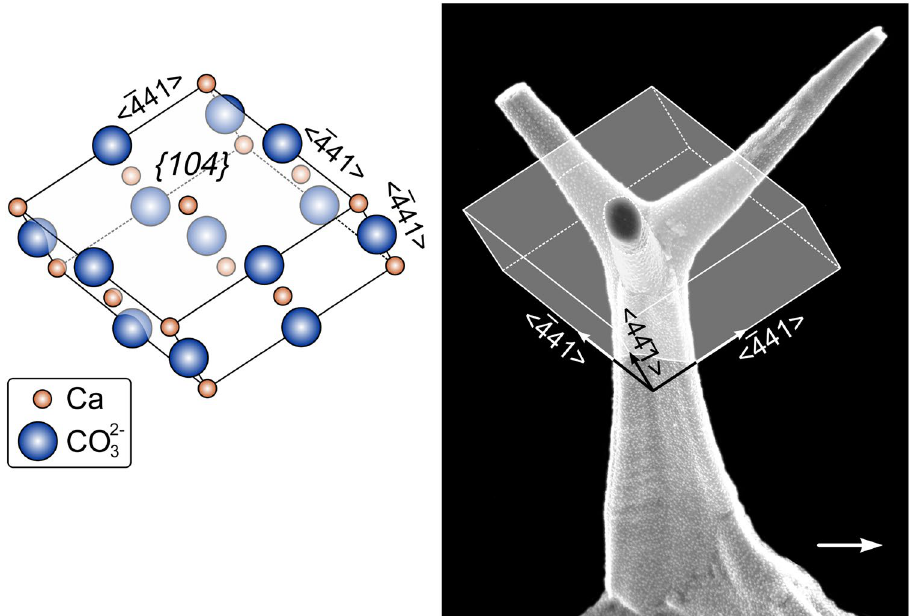
Figure 7. Crystallographic model for the second-order aerials of Catillopecten . The stem coincides with the c-axis (i.e. the line joining the upper and lower vertices of the {104} calcite rhombohedron, to the left), whereas the branches are aligned with the edges of the same rhombohedron (< − 441 > directions). The right sketch shows an aerial of C. natalyae partly enclosed within a rhombohedron, in approximate crystallographic coincidence. The arrow indicates the shell growth